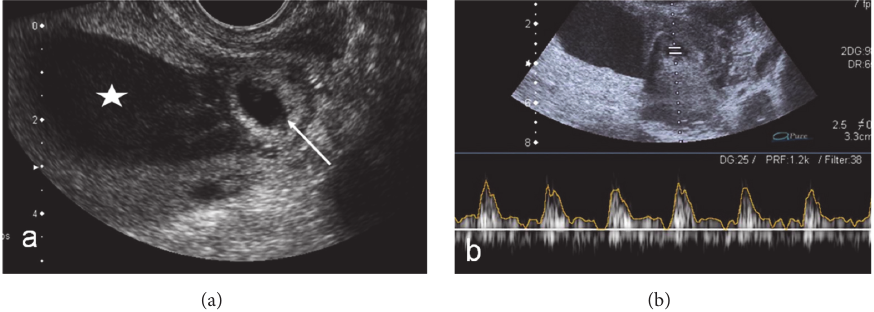
Figure 1: (a) A TVUS examination showing the gestational sac (arrow) near isthmus, close to previous cesarean section scar, and hemorrhagic fluid in endometrial cavity (star). (b) Spectral Doppler US showing the fetal pole and fetal heart rate in gestational